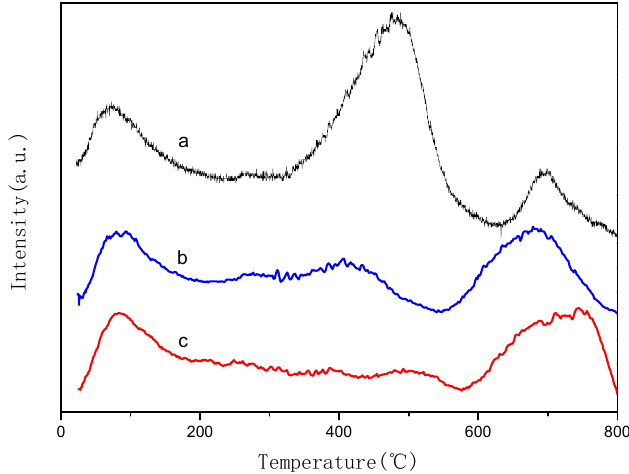
Figure 5. O 2 -TPD profiles of ( a ) 0.2% Pd/TiO 2 , ( b ) 0.2% Pd-0.5% Ce/TiO 2 , and ( c ) 0.2% Pd-3% Ce/TiO 2.